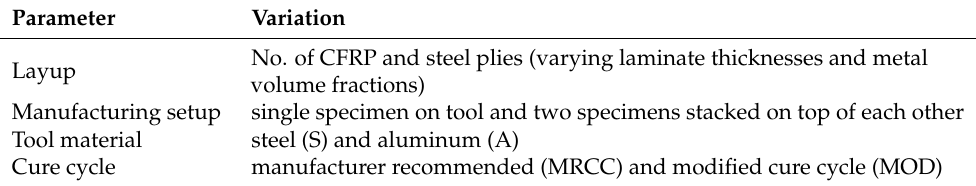
Table 2. Parameters influencing the residual stress state and variations investigated in this work.